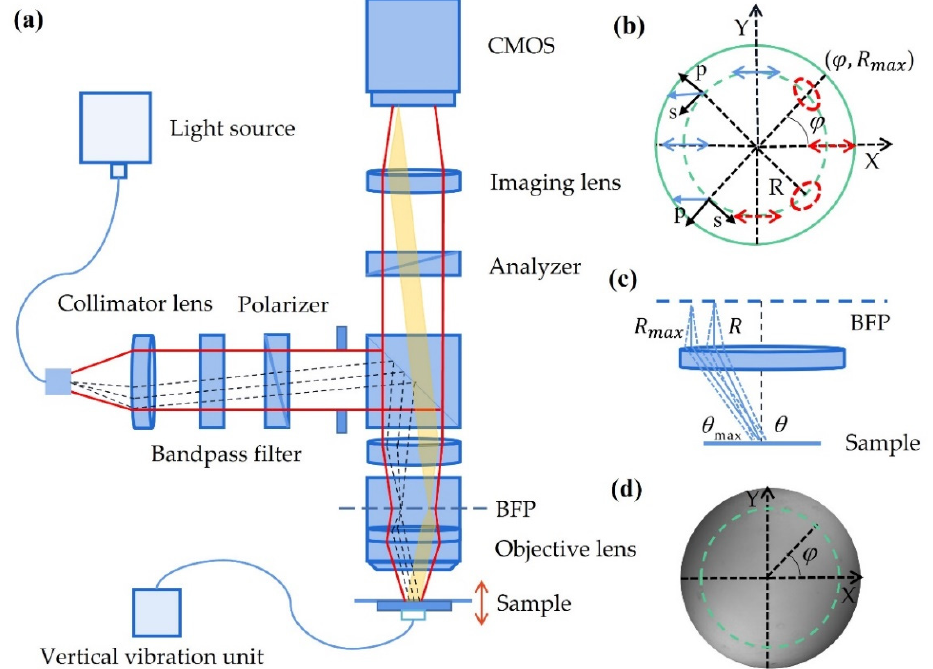
Figure 1. The measurement principle of BFP ellipsometry: ( a ) hardware configuration; ( b ) polariza- tion change of incident and reflected beams denoted in blue and red, respectively; ( c ) the relationship between the BFP radius R and incident angle θ ; ( d ) the BFP image of a SiO 2 film.